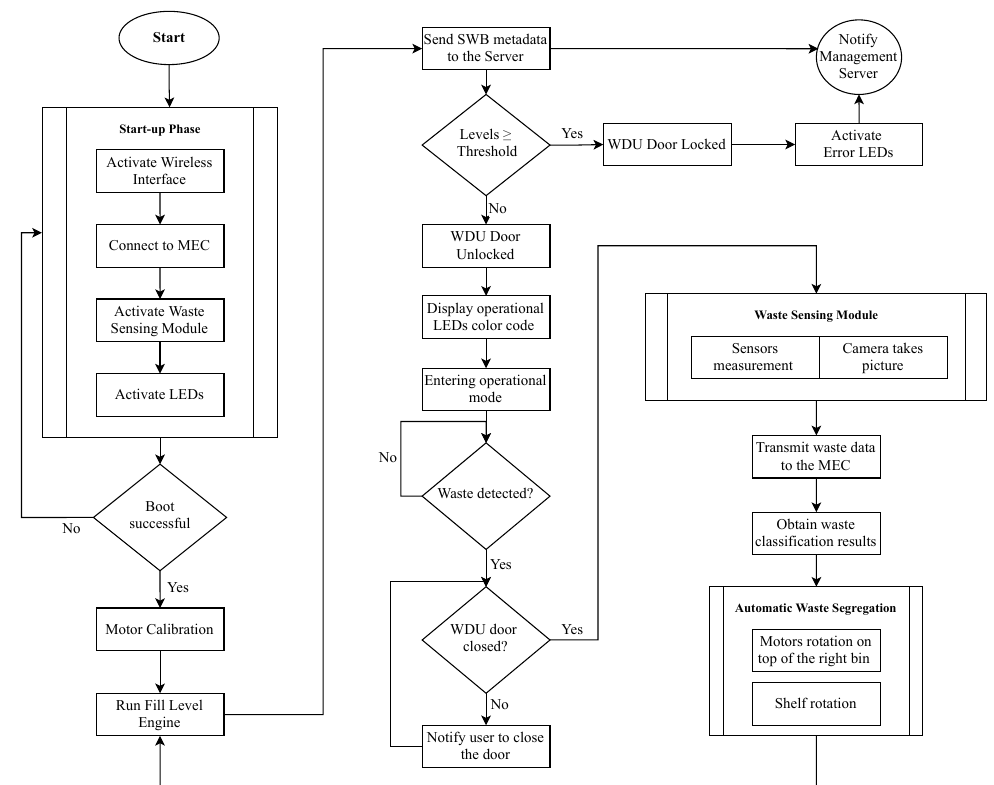
Figure 7. Functional flow diagram of the smart waste